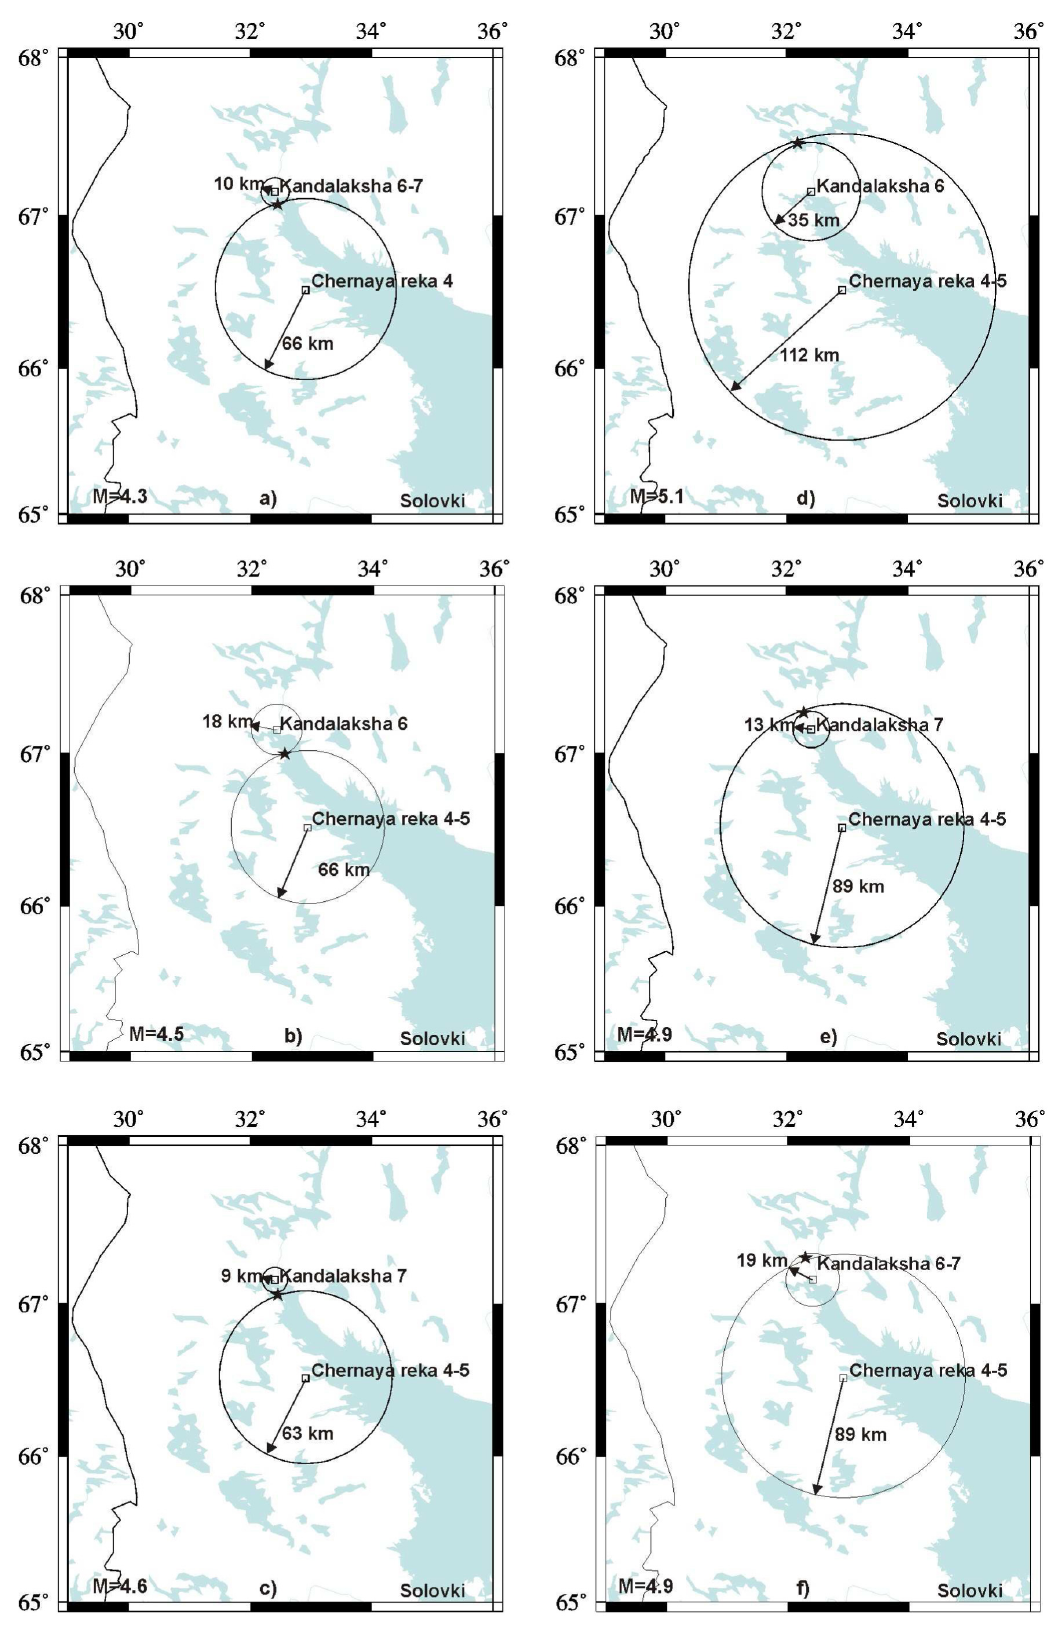
Figure 4. Stars denote possible epicenters for the earthquake of December 17, 1758 when magnitudes are assumed to be 4.3 (a), 4.5 (b), 4.6 (c), 5.1 (d), 4.9 (e), and 4.9 (f). Intensities in Kandalaksha and Chernaya reka were assessed according to the description in the newspaper Sankt- Peterburgskiye Vedomosti [1759] (see Table